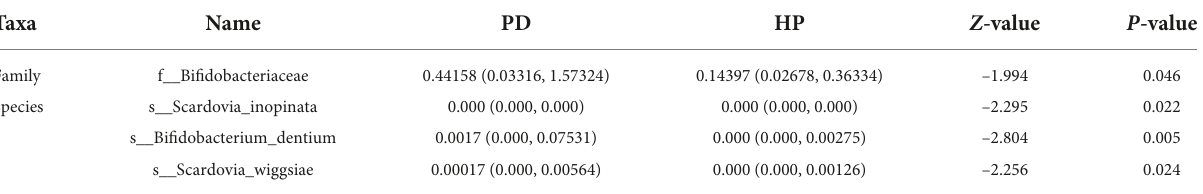
TABLE 2 Altered families, genera, and species in the metagenomic validation